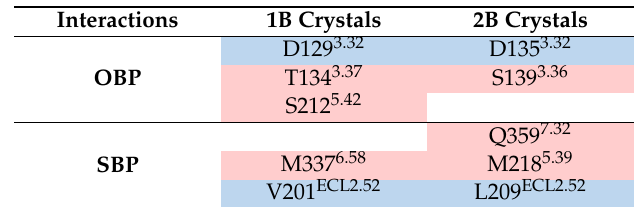
Table 5. All of the interactions considered during the pose filtering phase. The blue cells represent hydrogen bonds, and the red cells represent distance criterion ( ≤ 5.0 Å between the compound and any atom of a residue). OBP: orthosteric binding pocket; SBP: secondary binding